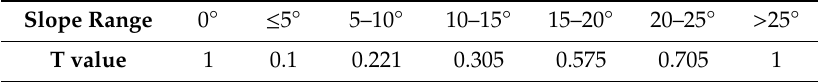
Table 3. T value under the di ff erent slope